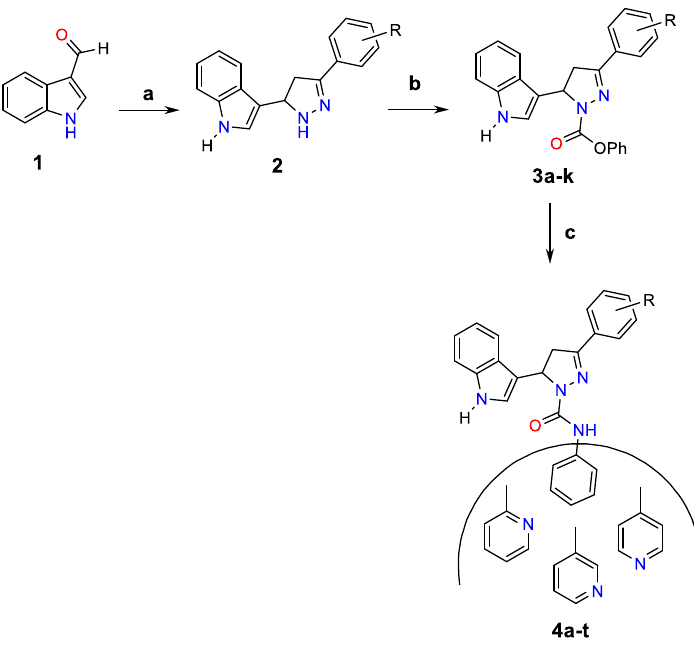
Figure 1. Scheme for the synthesis of indolyl pyrazolines. a. NaOH, NH 2 NH 2 , 6-8h, reflux, b. THF, (Et) 3 N, phenyl chloroformate, 2h, below 5 °C, c. Ar-NH 2 , RT, stirring, 3 – 4h.